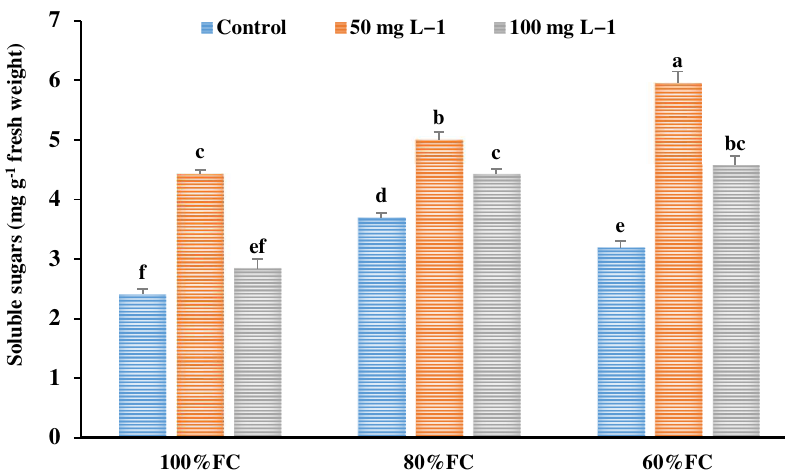
Figure 3. The soluble sugar content of basil in different irrigation regimes and Se NPs. Different letters indicate significant differences at the 5% level according to LSD’s test.